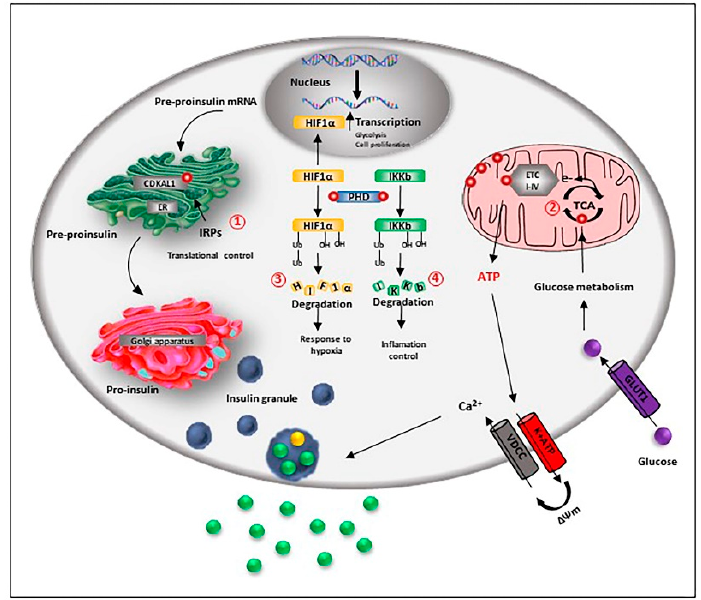
thus affecting oxidative phosphorylation and insulin release [34].